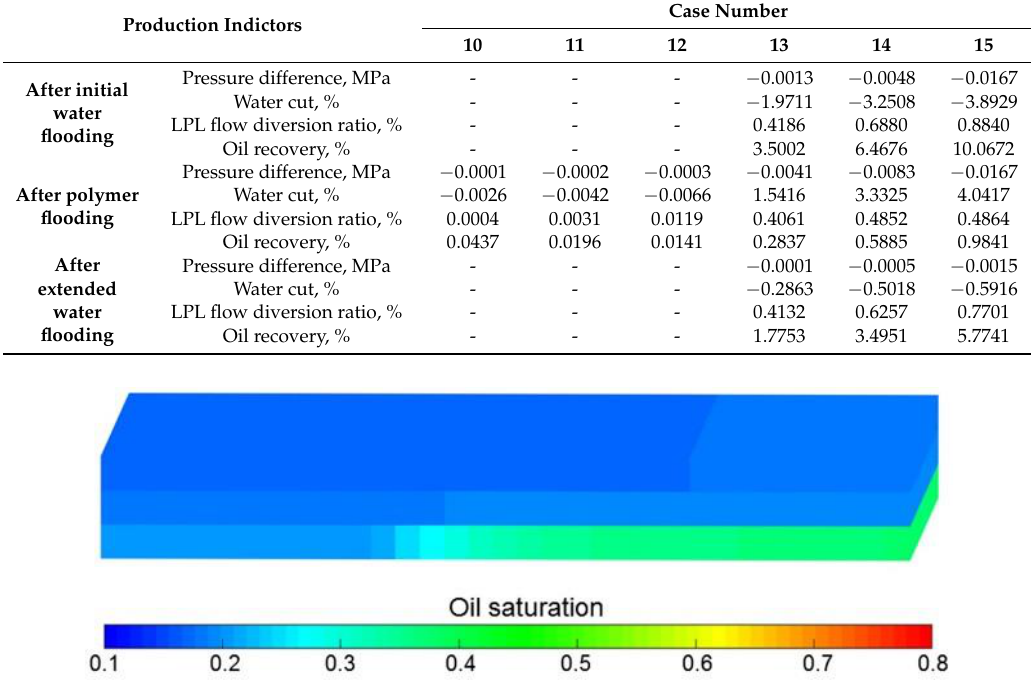
Figure 17. 3D remaining oil saturation distributions after polymer flooding of Case 12.